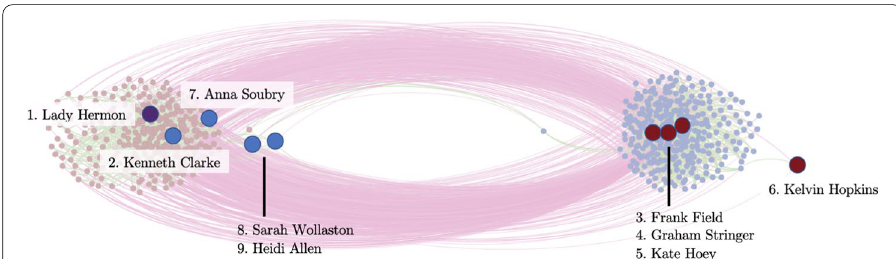
Fig. 4 The eigenvector centrality measure correctly identified the top 9 of 10 rebels. Note that Lady Hermon was labeled an Independent rebel in the Data and Methods